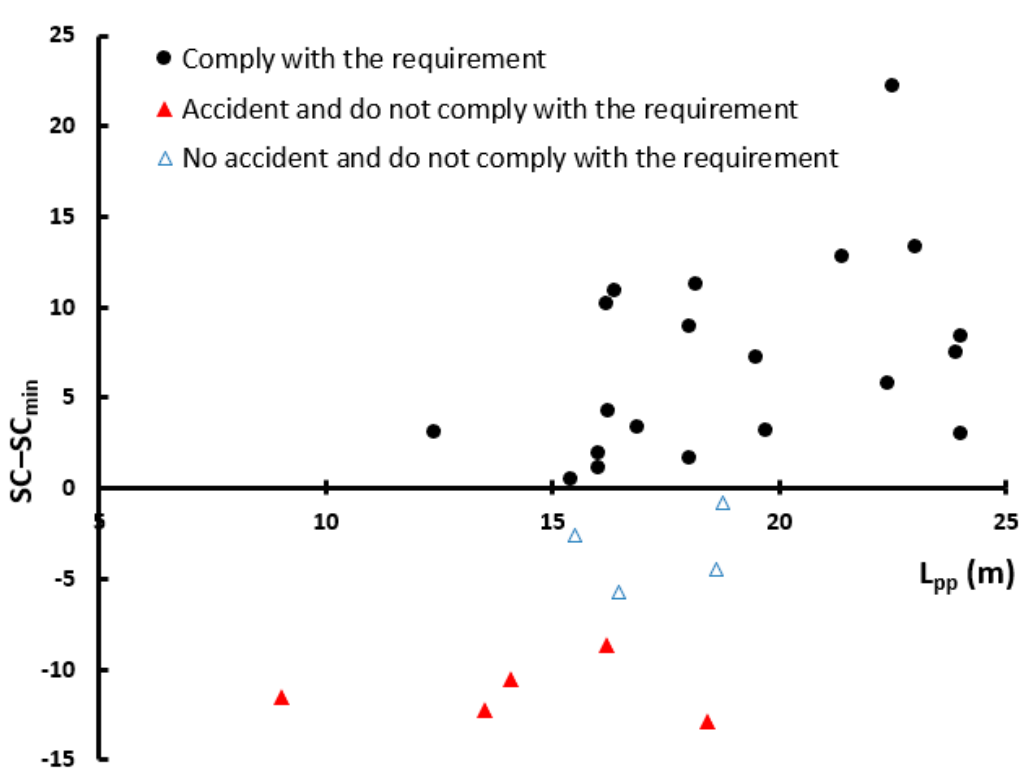
Figure 9. The evolution of SC ‒ SC min difference of the analyzed vessels as a function of vessel length ( L pp ).